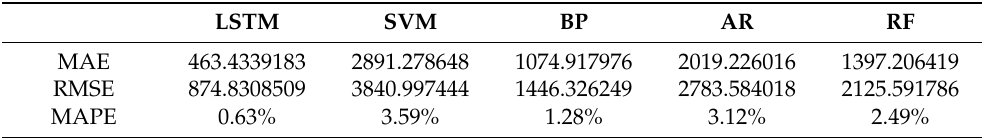
Table 4. Average results of different prediction